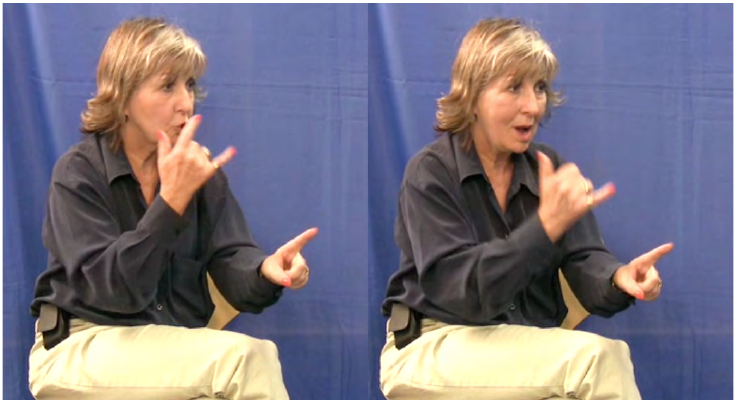
Figure 14. Indicating verb along the ‘body-sagittal’ axis used without constructed